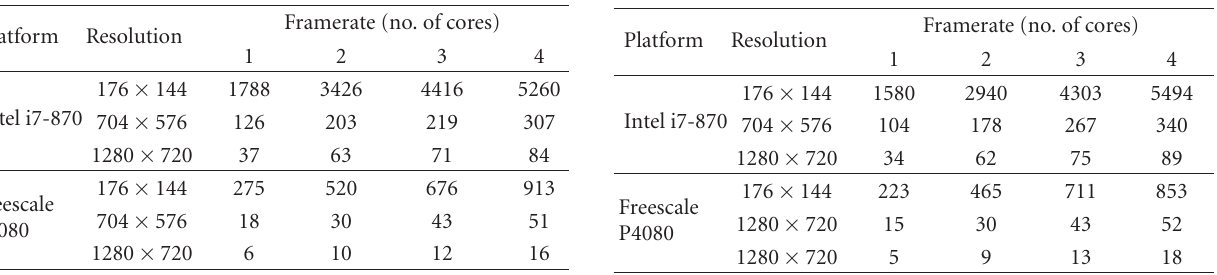
Table 1: Framerate of the serial MPEG-4 SP decoder at QCIF, SD and HD resolutions.